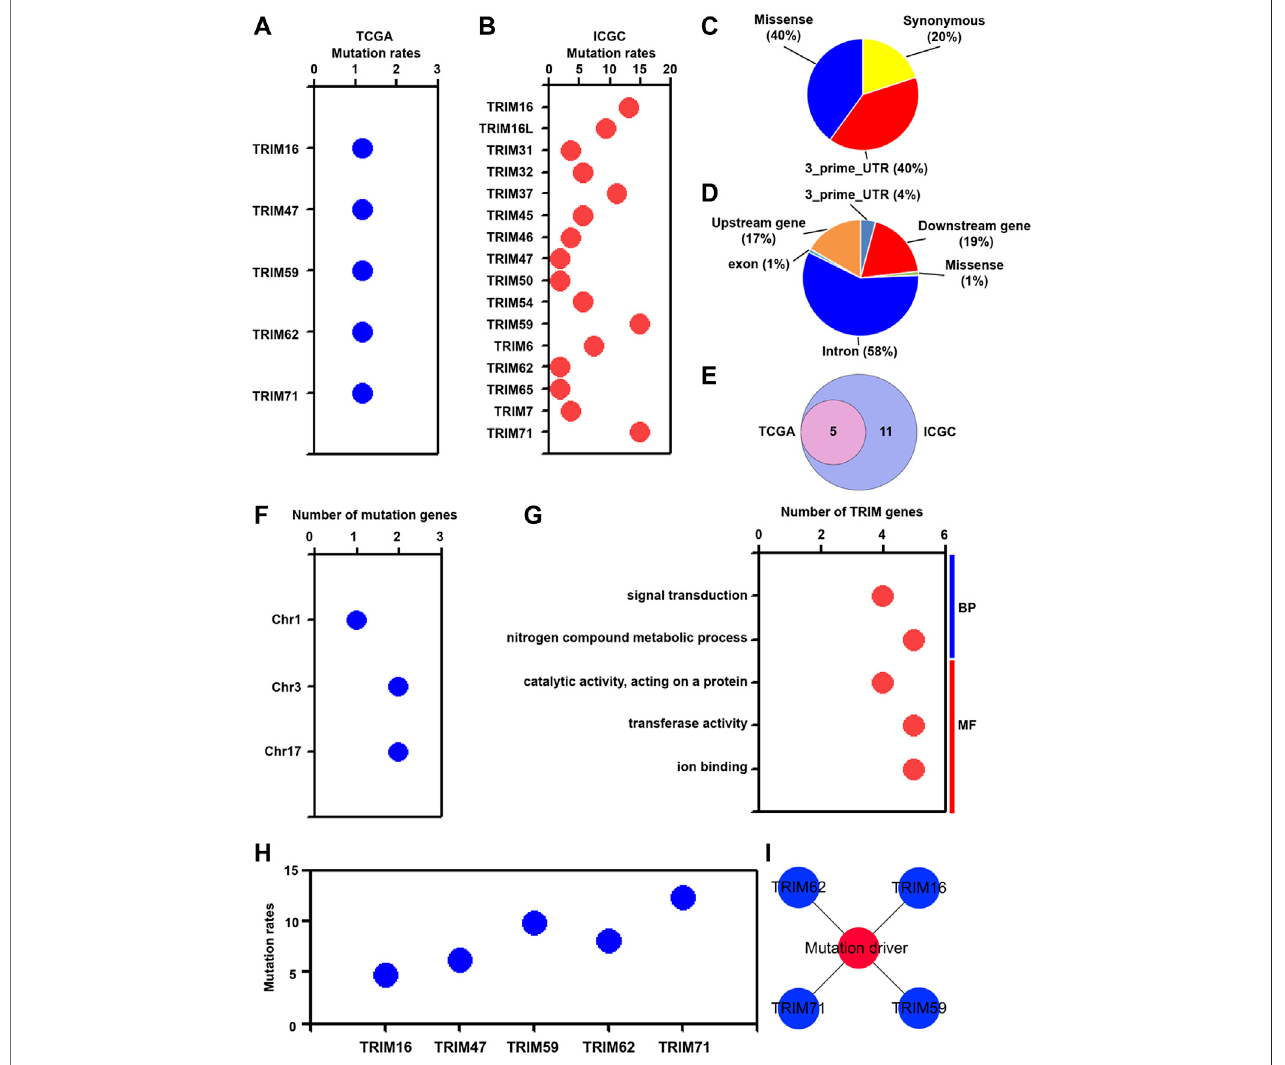
FIGURE5| The mutation characteristics ofTRIMs inHBV-positive HCC. (A) Themutationproportion ofTRIMs intheTCGA cohort. (B) The mutation proportion of TRIMsintheICGCcohort. (C) ThemutationtypesandtheirmutationproportionsintheTCGAcohort. (D) ThemutationtypesandtheirmutationproportionsintheICGC cohort. (E) The number of commonly mutated TRIM genes in both TCGA and ICGC cohorts. (F) The colocation of TRIM genes in different chromosomes. (G) The GO terms of common mutated TRIMs. (H) The mutation proportion of common TRIMs in the LICA-CN cohort. (I) The mutation drivers are related to identi fi ed TRIMs.